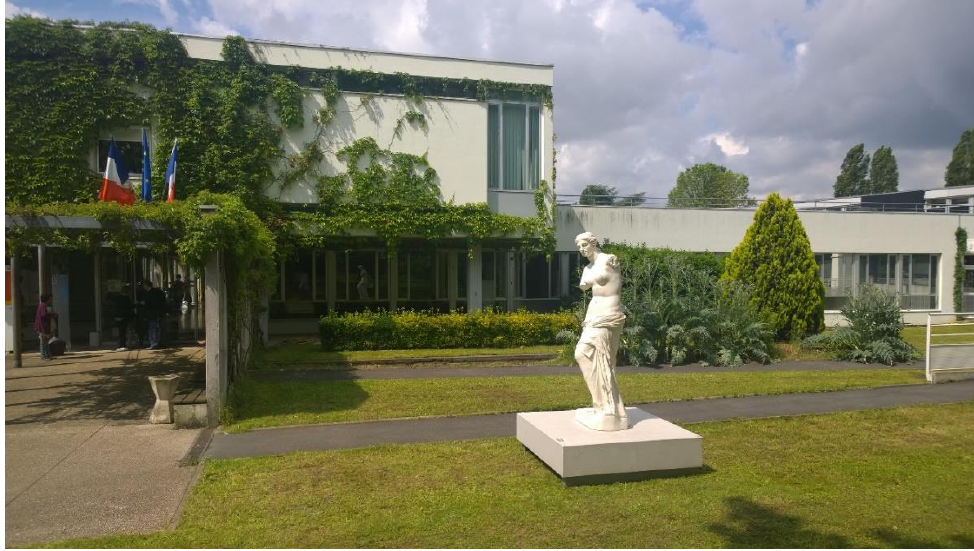
Figure 1. The copy of the Venus de Milo in the hospital garden.